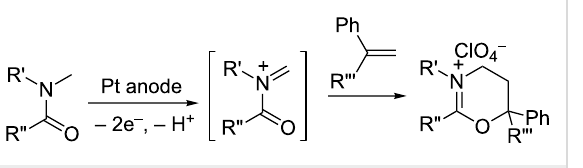
Scheme 5: Type of products obtained ( n = 0, 1,